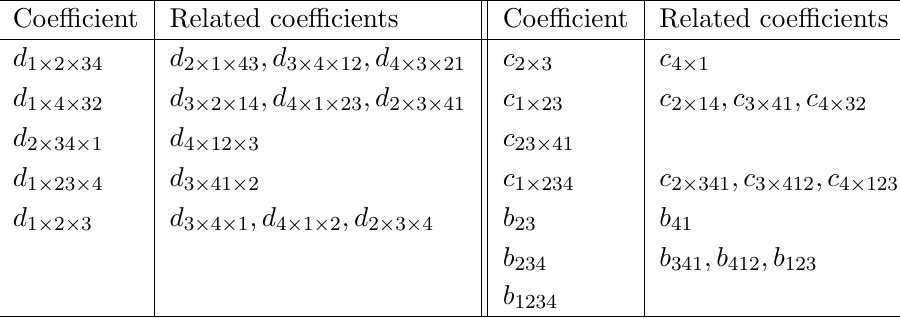
Table 4 . Minimal set of integral coe(cid:14)cients for 1 +